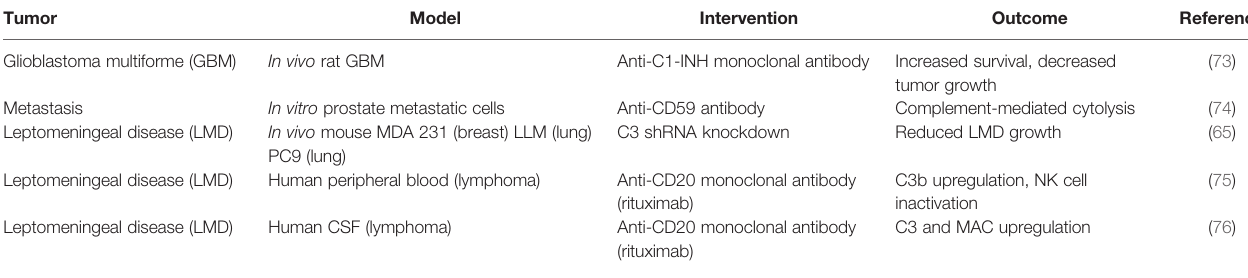
TABLE 2 | Exogenous complement modulation as treatment in brain